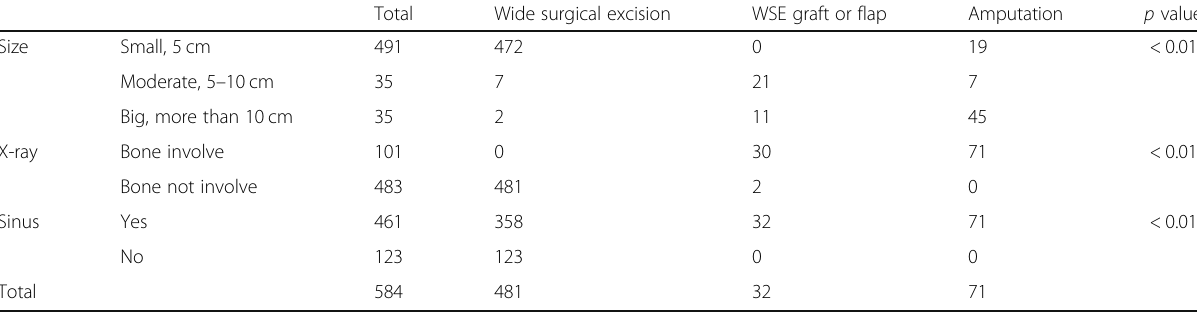
Table 2 Factors associated with types of surgical operation ( N = 584)